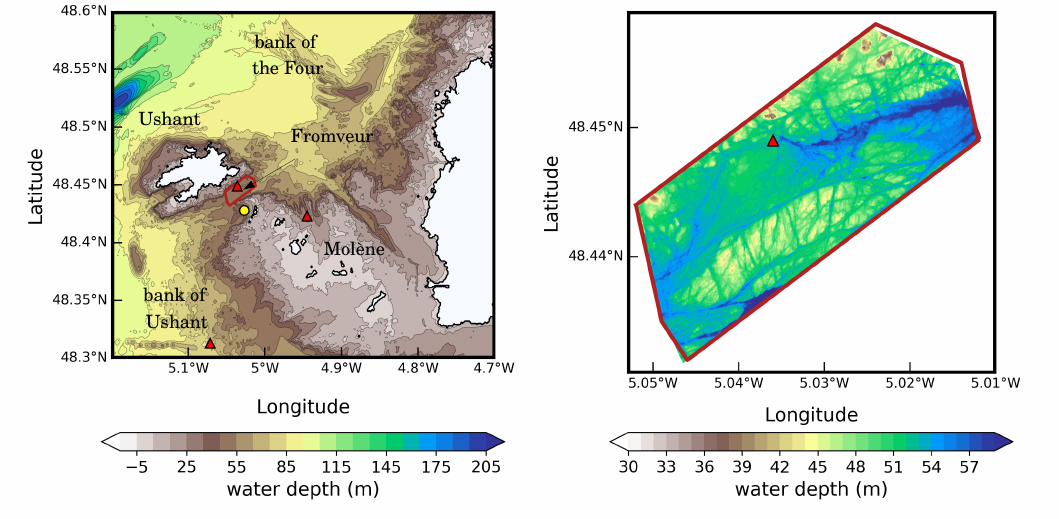
Figure 2. ( left ) Mean water depth of Ushant-Molène archipelago. ( right ) High-resolution bathymetry of the Fromveur Strait referenced to the lowest astronomical tidal water level (french “zéro hydrographique” reference). To be consistent with Figure 1, locations of current meters and wave buoys over the two geographical areas are indicated with red triangles and yellow circles, respectively. The red line delimits the area of interest for the implementation of turbines within the Fromveur